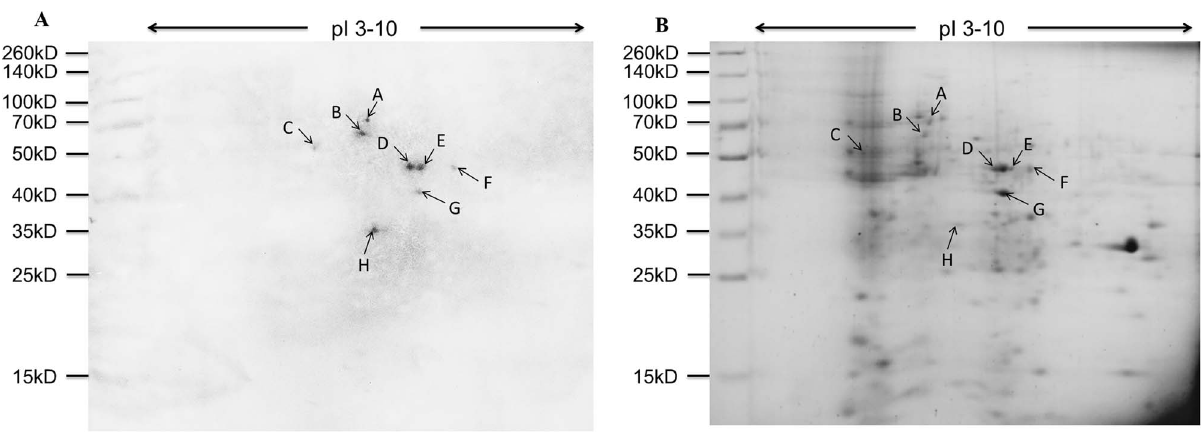
Fig. 3. Virus binding experiment on total proteins of B. mori midgut resolved by 2-DE. A) Virus overlay binding experiment. B) Separation of B. mori midgut total proteins by 2-DE. Molecular mass was indicated on the left and isoelectric point (PI) range on the top. Arrows named A to H in A) and B) referred to the detected spots on PVDF membrane and the corresponding proteins in gel, respectively.